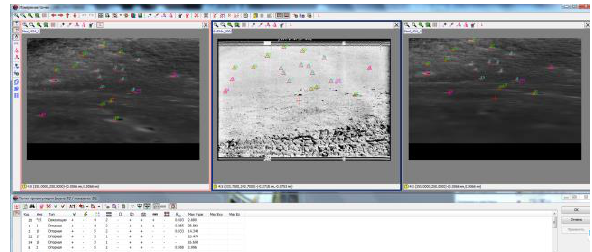
Figure 3. Example of measurements of ground control points and tie-points on original image. Real (unknown) fragment of panorama #434 is in the middle.